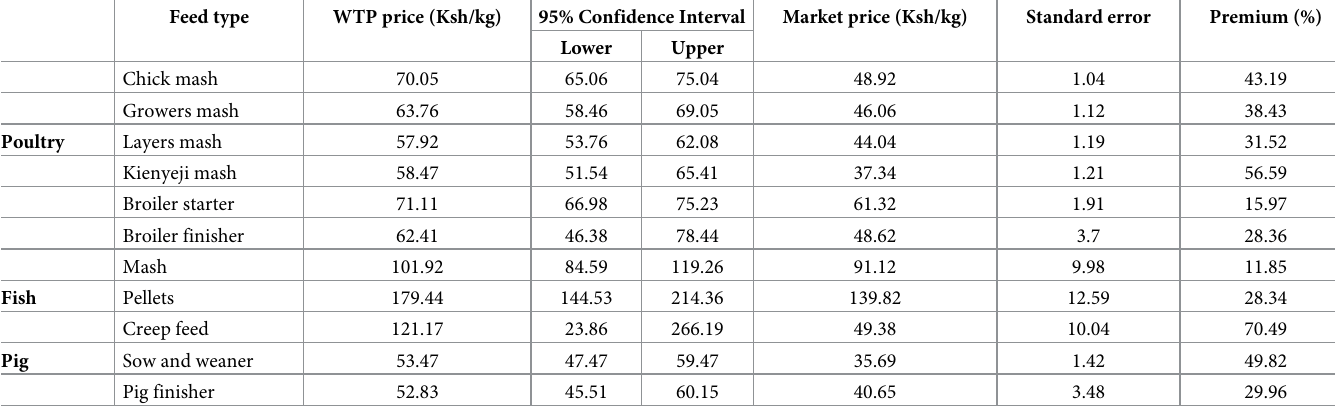
Table 4. Farmer’s willingness to pay (WTP), confidence intervals and mean price premium (percentage change) for insect-based feed. Feed type WTP price